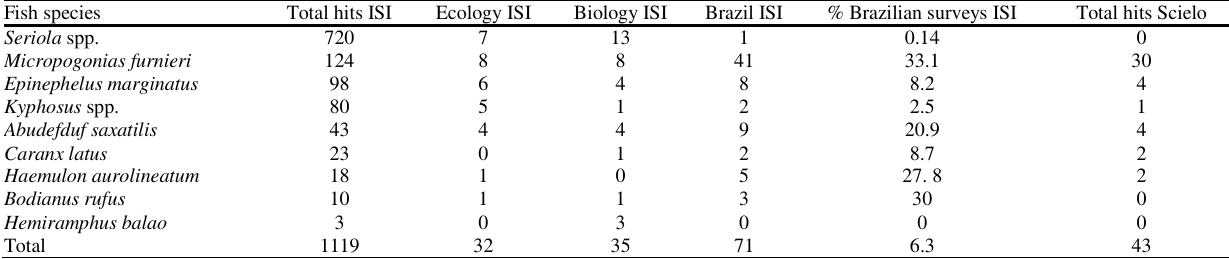
Table 5. Search results for scientific publications about the studied fishes, using two search engines on July 2010: ISI Web of Science (http://apps.isiknowledge.com) and Scielo (http://www.scielo.org), which includes Brazilian journals that may not appear on ISI. Total hits are total number of articles found, plus hits found using the key-words: ecology, biology and Brazil or Fish species Seriola spp.